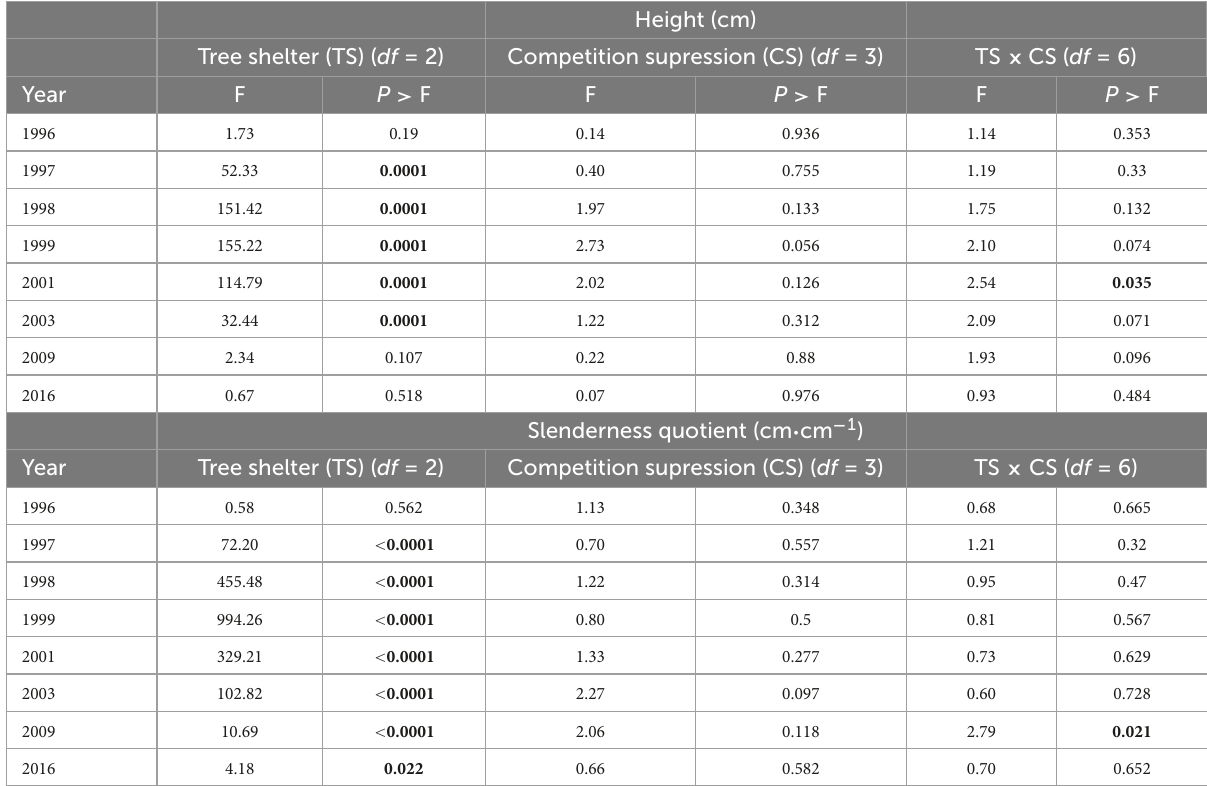
TABLE 2 Results from ANOVA (Snedecor F and associated probability P ) test for height and sturdiness quotient along 20 years of P. halepensis planted in a factorial experiment with tree protection (no shelter, mesh, and tube-shelter) and four competition suppression (control, manual weeding, polyethylene film, and coconut mulches)